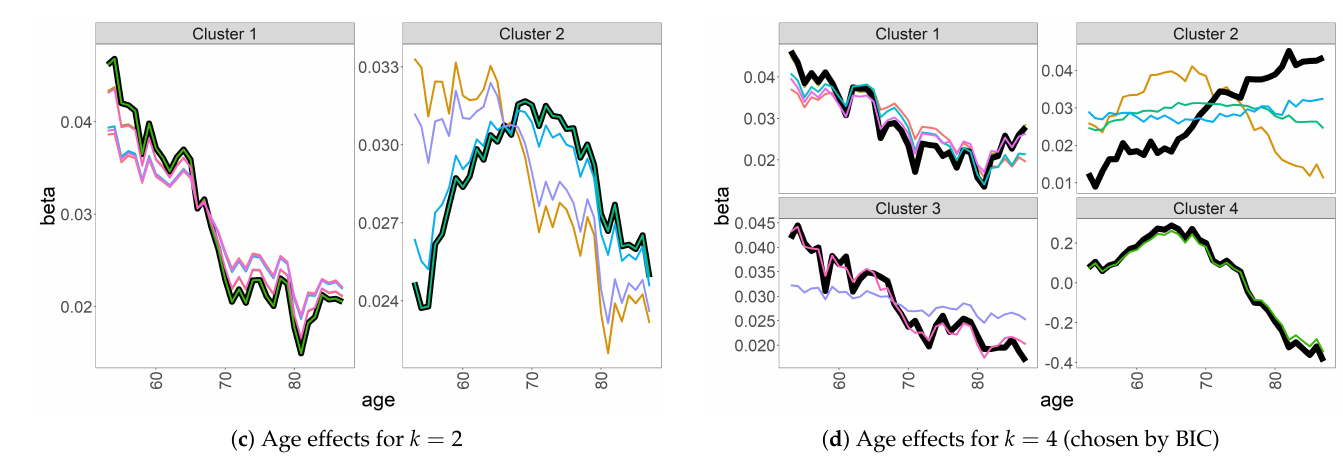
(cid:16) (cid:17) β l x as well as fitted population-specific age effects x